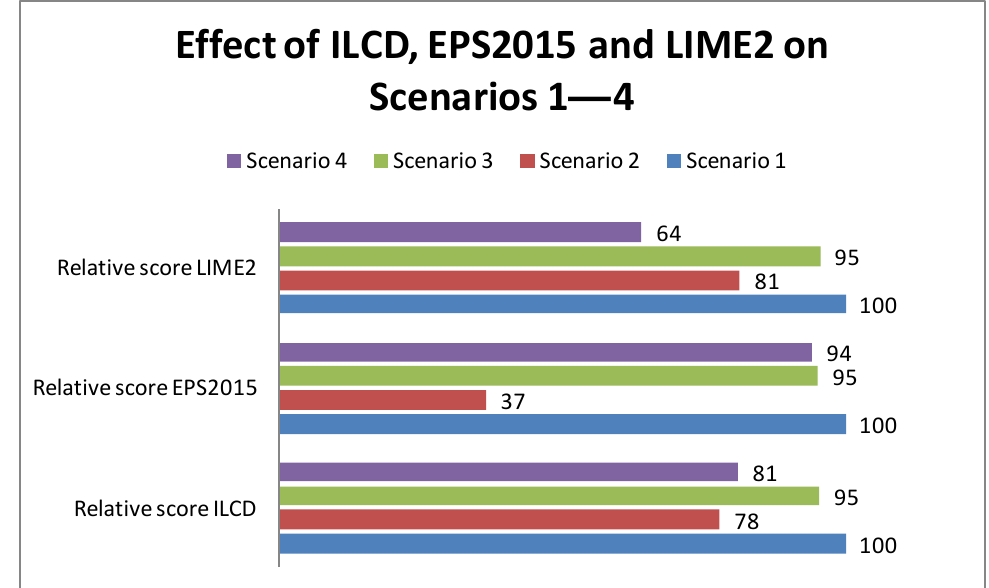
Figure 5. Relative screening LCA results for the VR headset for Scenarios 1–4 for ILCD, EPS2015, and LIME2.